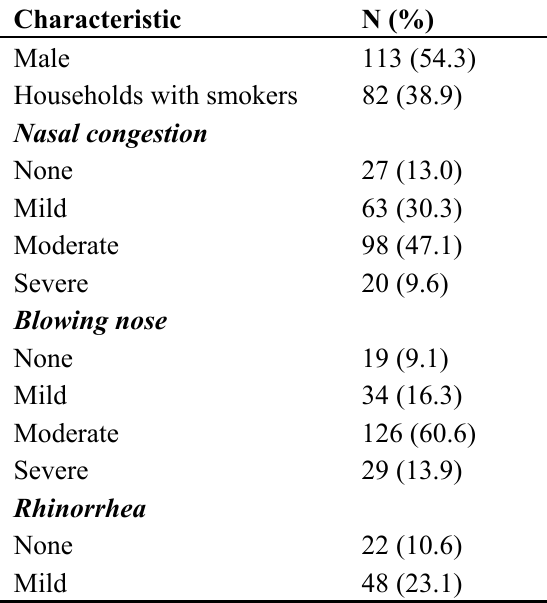
Table 1. Characteristics of the sample with frequency of rhinitis and sinusitis symptoms and parental policies regarding children’s exposure to second hand